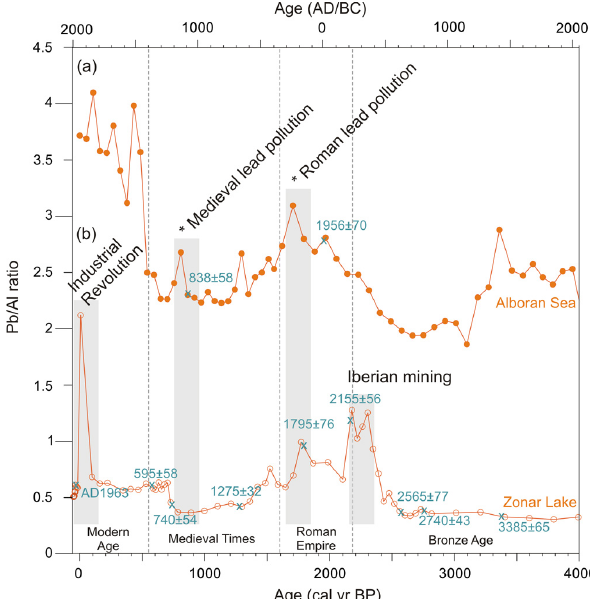
Fig. 3. Pb/Al ratios from (a) the Alboran basin (core ODP976) and (b) Zo˜nar Lake. 14 C and 137 Cs data are included. Gray bars indicate lead pollution